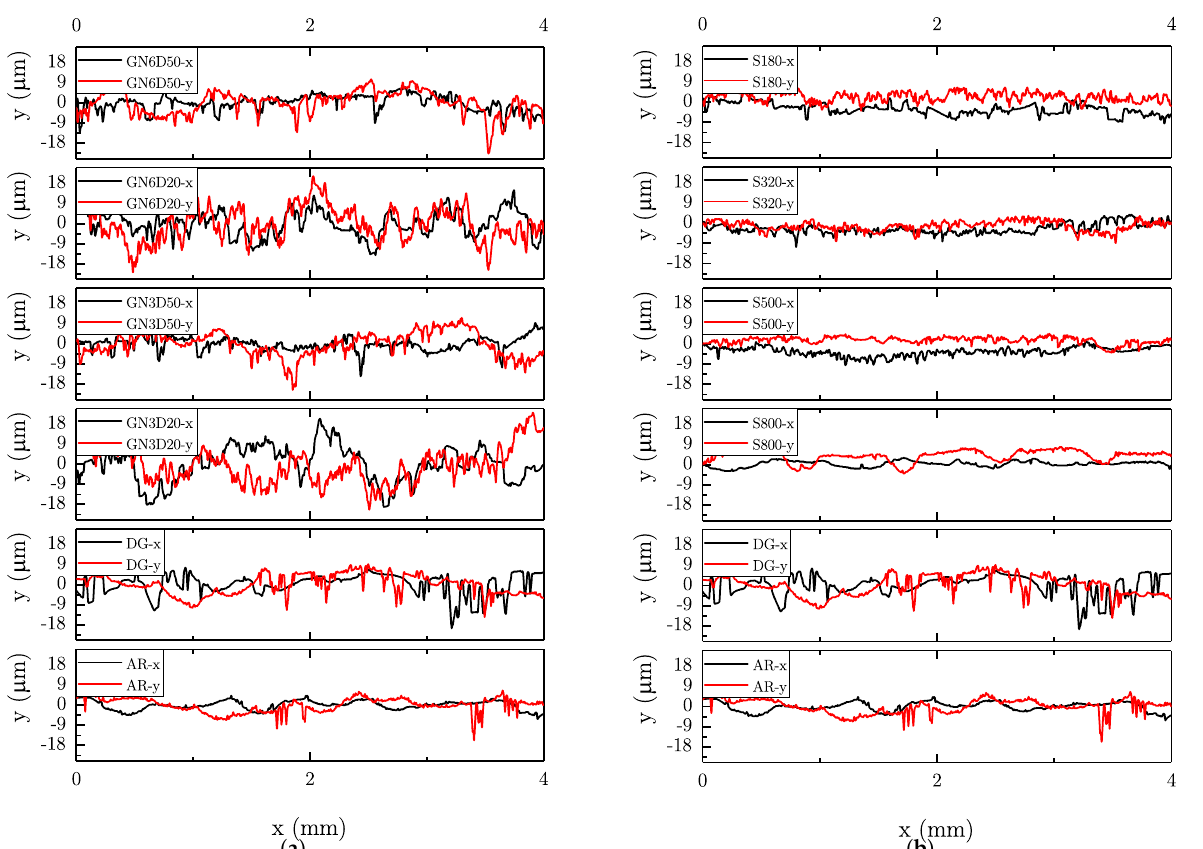
Figure 6. Surface profiles of CFRP plates: ( a ) grit-blasted and ( b ) sanded surfaces.